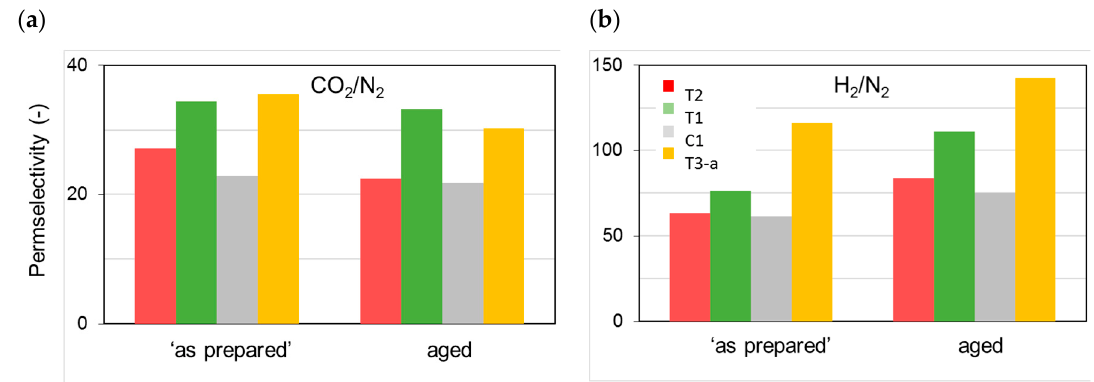
Figure 5. Permselectivity for the different HF samples tested “as prepared” and after long-term aging (30 months): ( a ) CO 2 / N 2 ; ( b ) H 2 / N 2 .